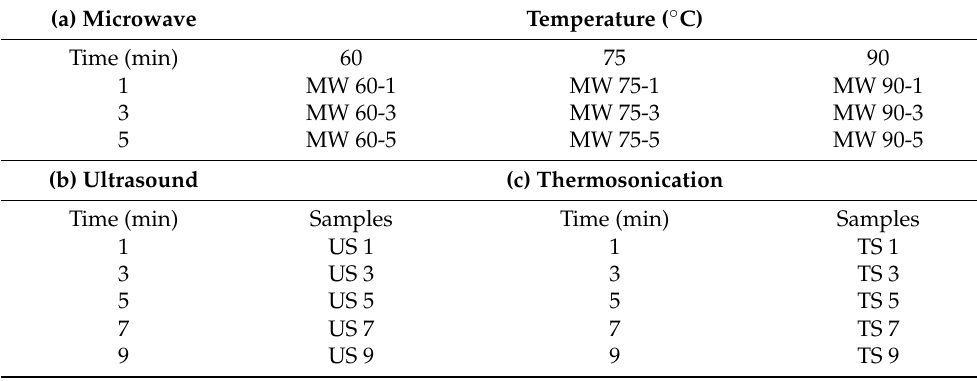
Table 1. Parameters for (a) microwave-processed samples; (b) ultrasound-processed samples, and (c) thermosonicated samples. Note: MW means microwave processing; US means ultrasound processing; TS means Thermosonication